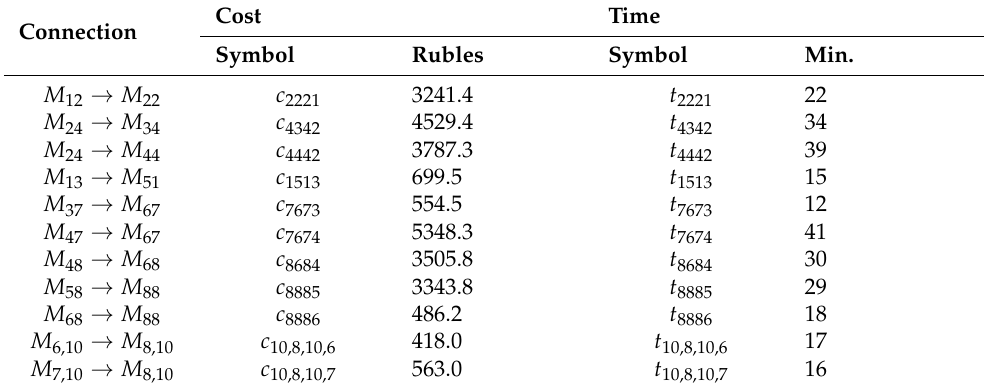
Table 5. Cost and time of inter-task connection.